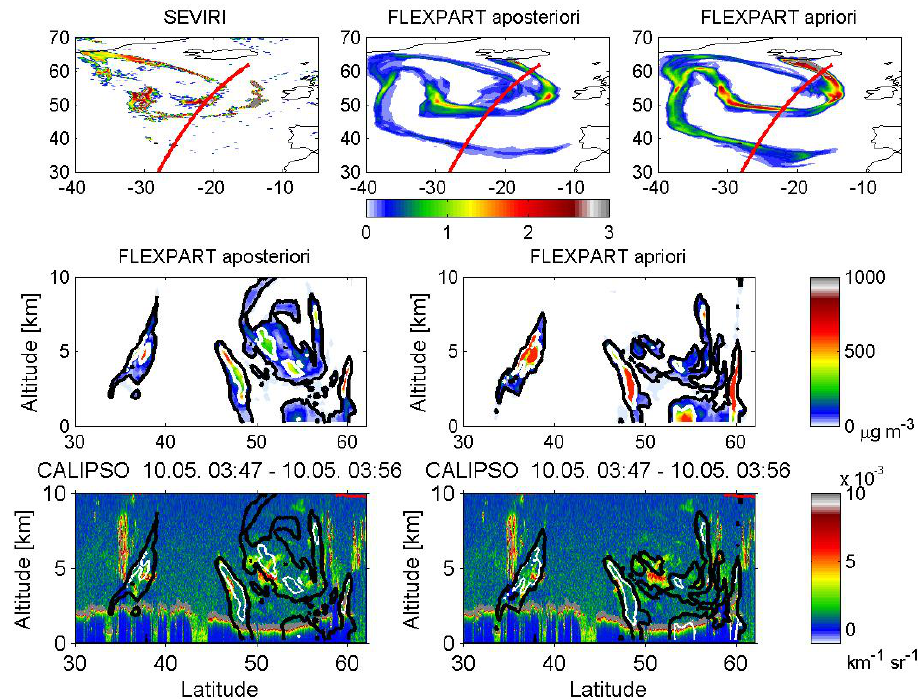
Fig. A3. Same as Fig. A1, but for 10 May at 04:00UTC.